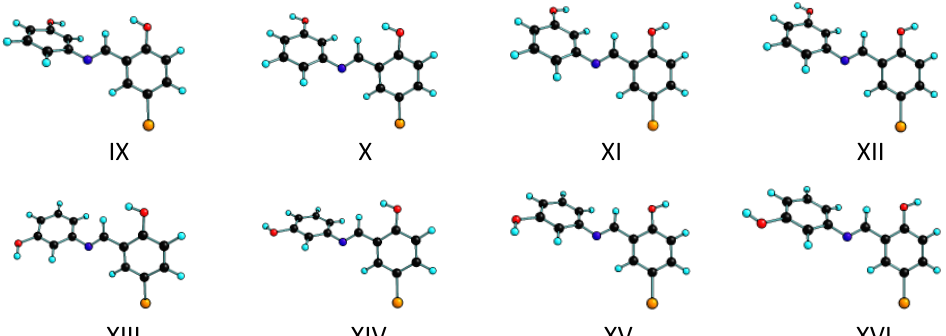
Figure 2. Conformers of the BHAP E -enol-imine form. The B3LYP/6-311++G(d,p) calculated opti- mized Cartesian coordinates of each conformer are provided in the Supporting Information Table S1. The conformationally relevant dihedral angles α, β, ϒ , δ are indicated over the structure of con- former I. Note that all conformers have a symmetry related structure.